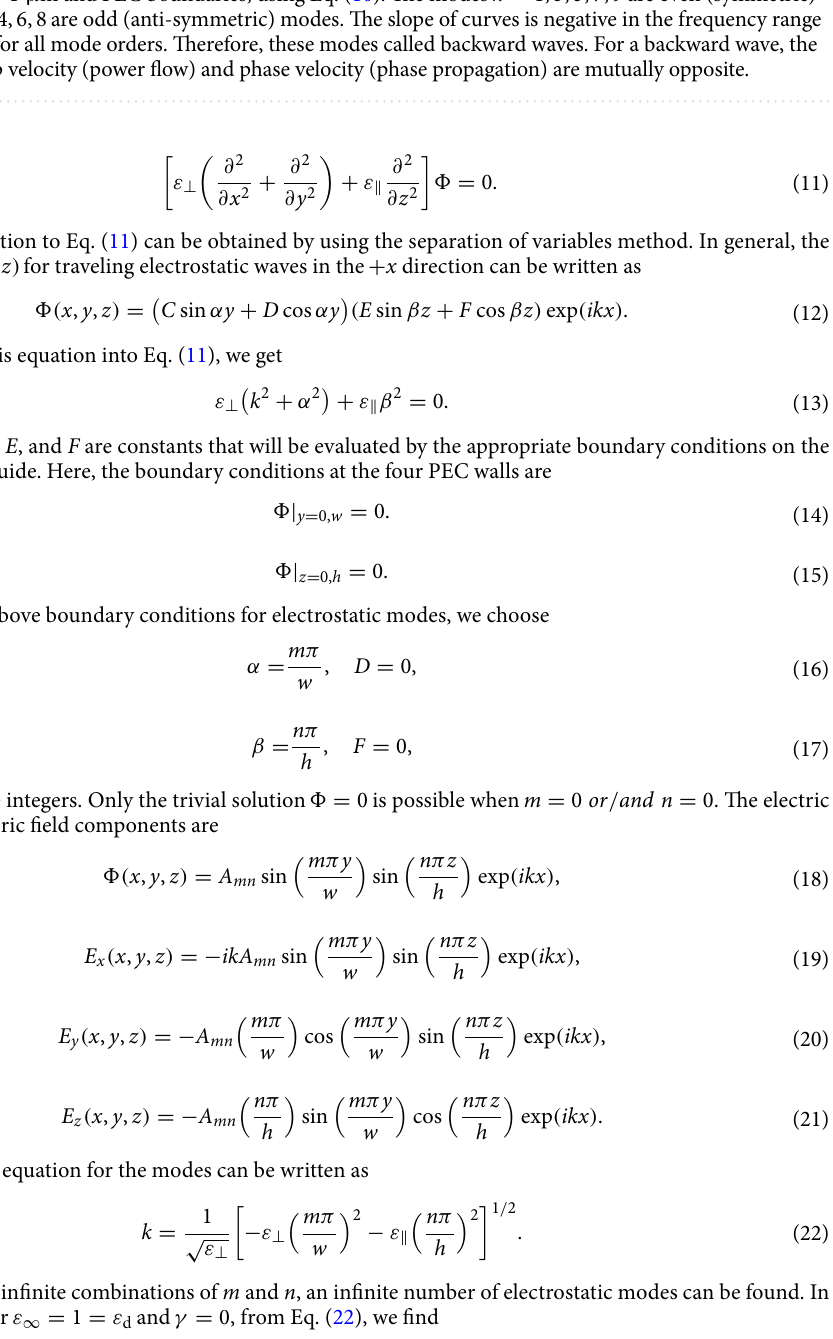
1, 3, 5, 7, 9 are even (symmetric) =